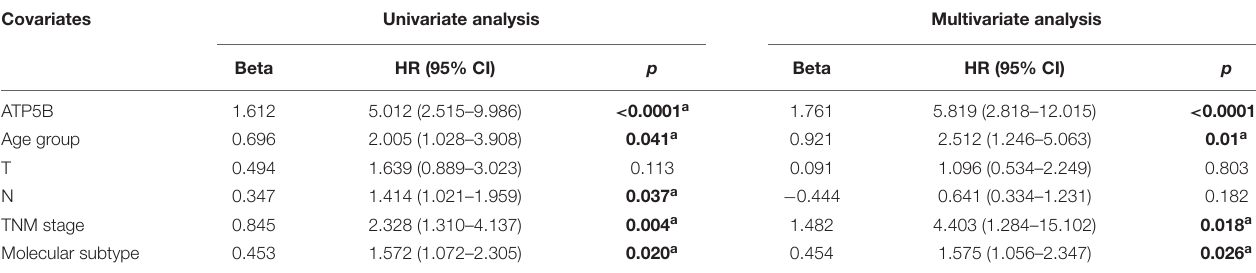
TABLE 2 | Uni- and multivariate analysis of covariates of OS.